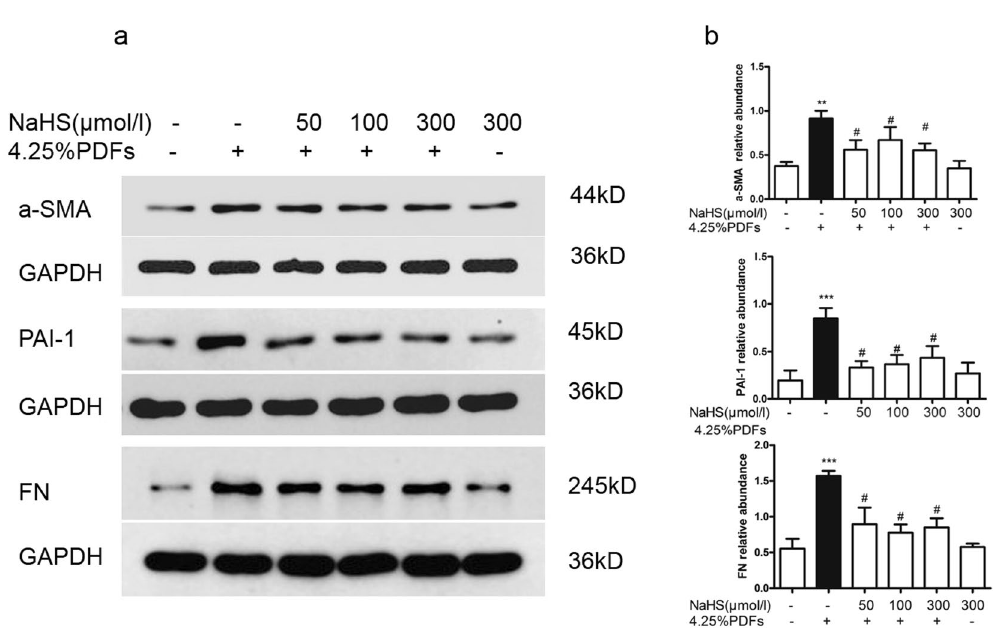
Figure 4. Effect of H 2 S on fibrogenic factors induced by 4.25% glucose PDFs in RPMCs. RPMCs were pretreated with or without NaHS (50, 100, 300 μ mol/L) for 30 mins, then exposed to the mixture of 4.25% glucose PDFs and culture medium by 1:1 for 24 h. ( a ) a-SMA, PAI-1 and fibronectin protein were detected by Western blot and ( b ) relative abundance of these proteins in each group are presented. Data represent mean ± SD of three independent experiments. ** P < 0.01 versus control group; # P < 0.05 vs. 4.25% glucose PDF